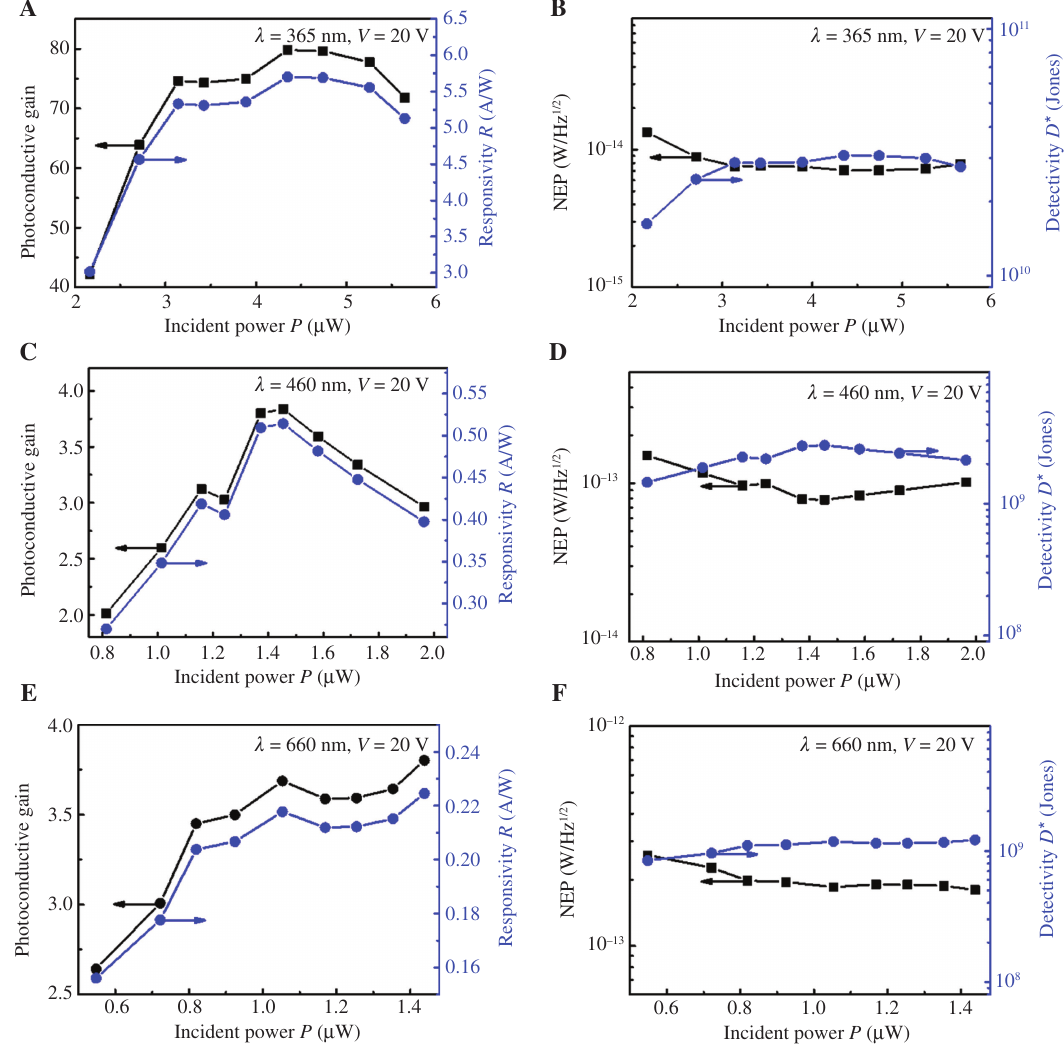
/SiC photodetector. 2 /SiC D-detector as a function of the incident light power for three incident light 2